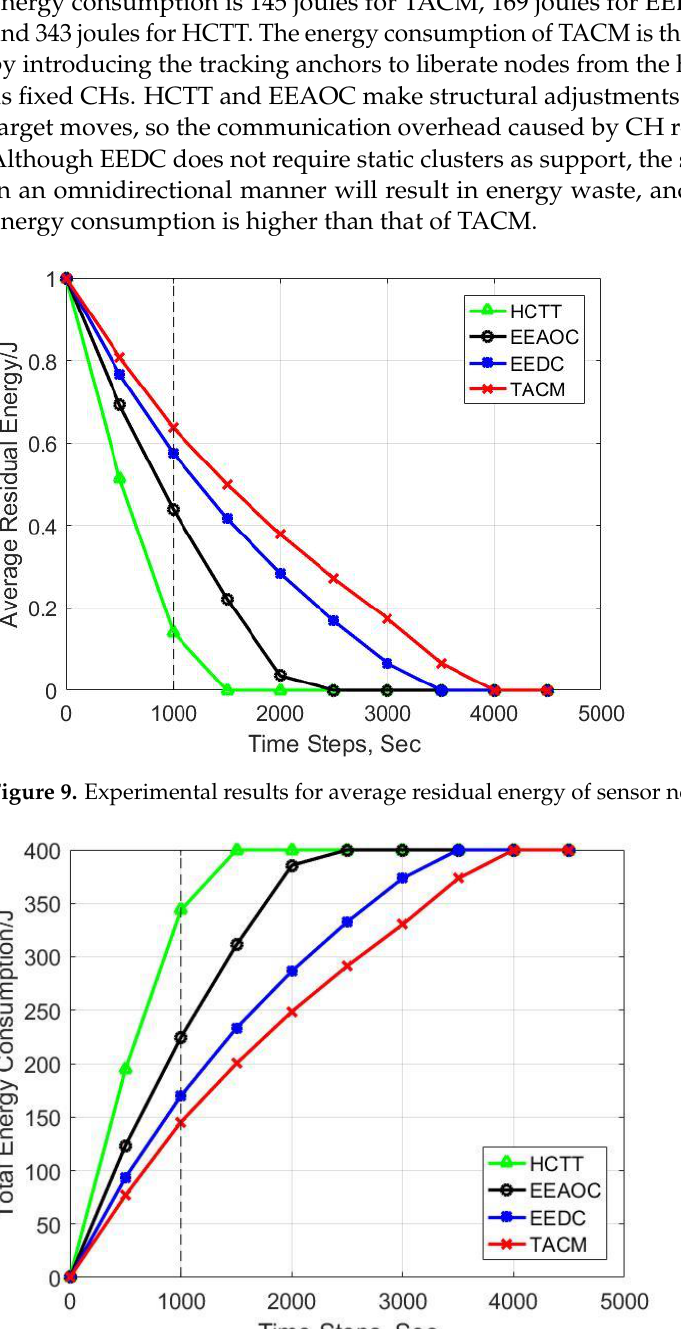
Figure 11. Experimental result for number of activated nodes in the network.